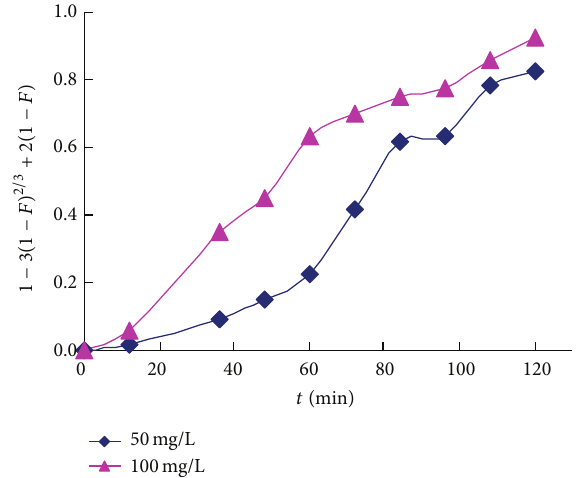
Figure 6: The fitting curves of the adsorption kinetics with different concentrations of solution.